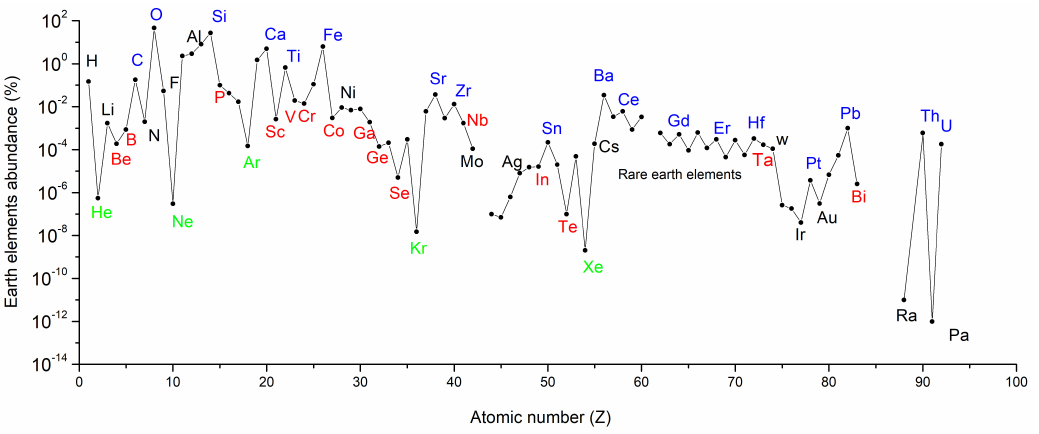
Figure 8. Earth-abundant elements as a function of their atomic number (Z) [49].